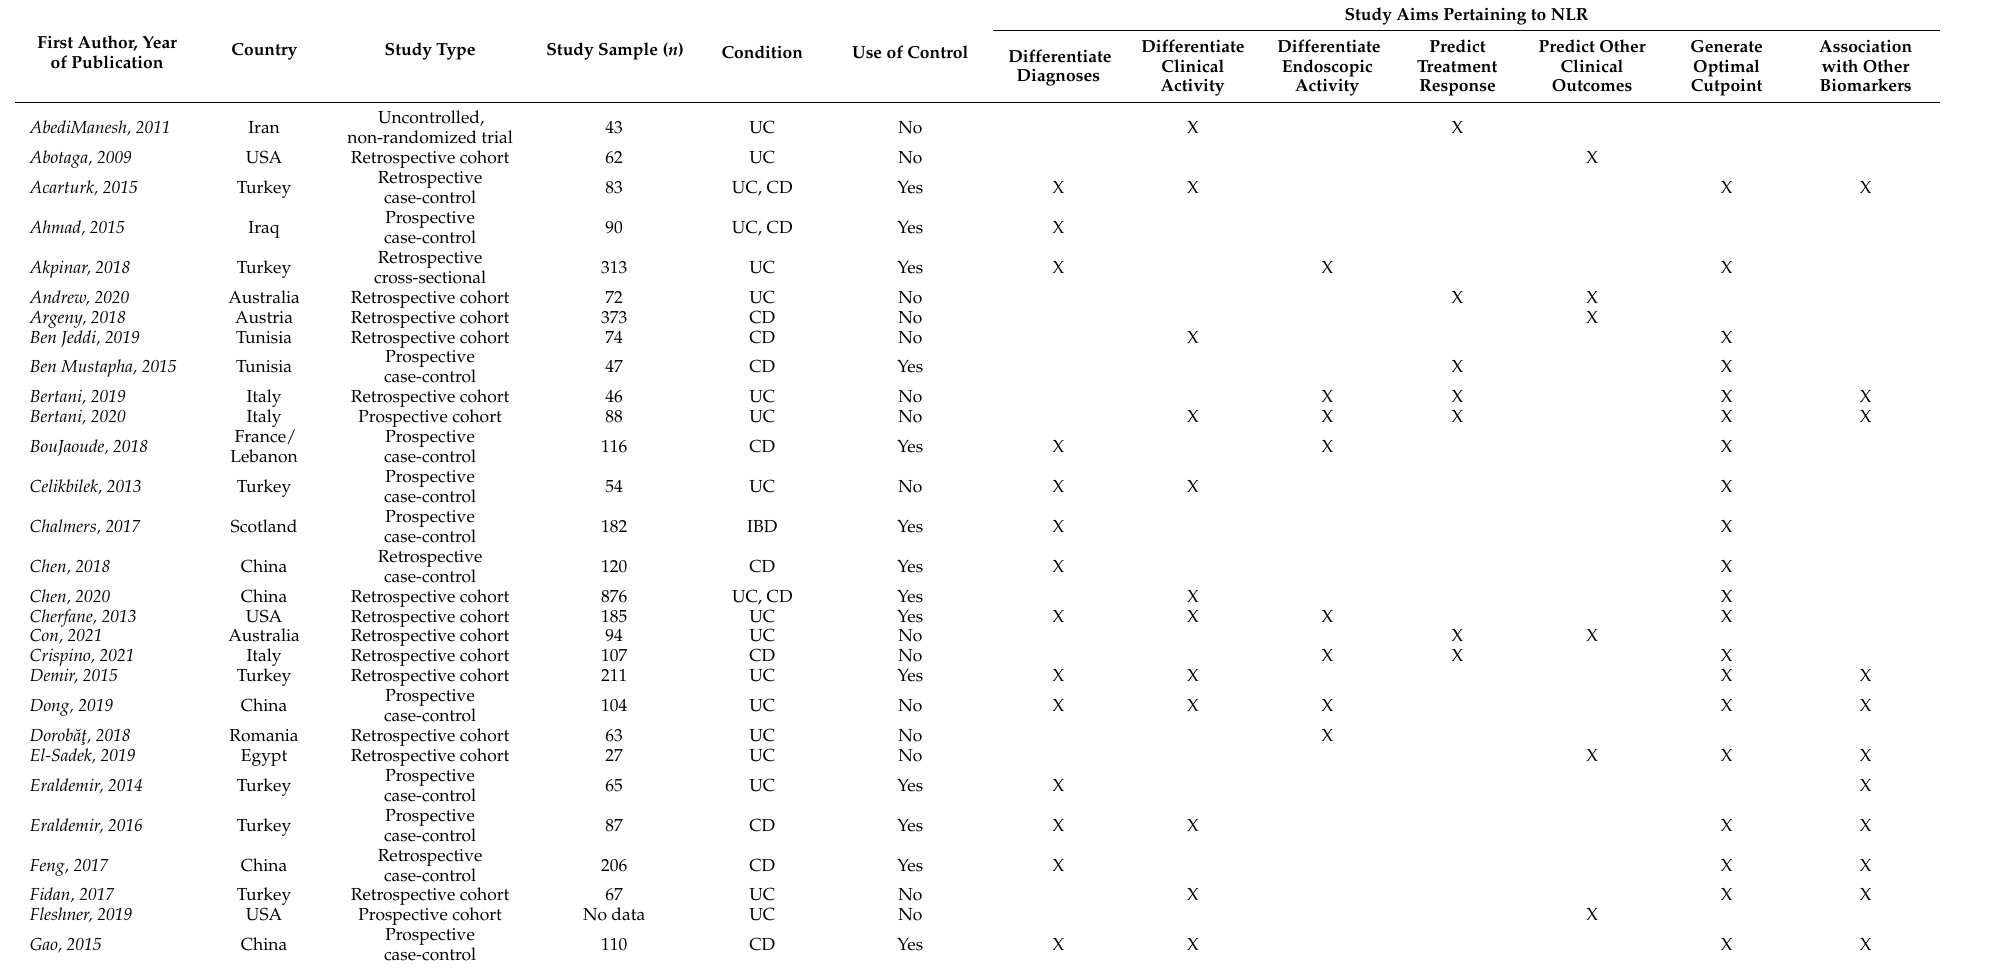
Table 1. Characteristics of included